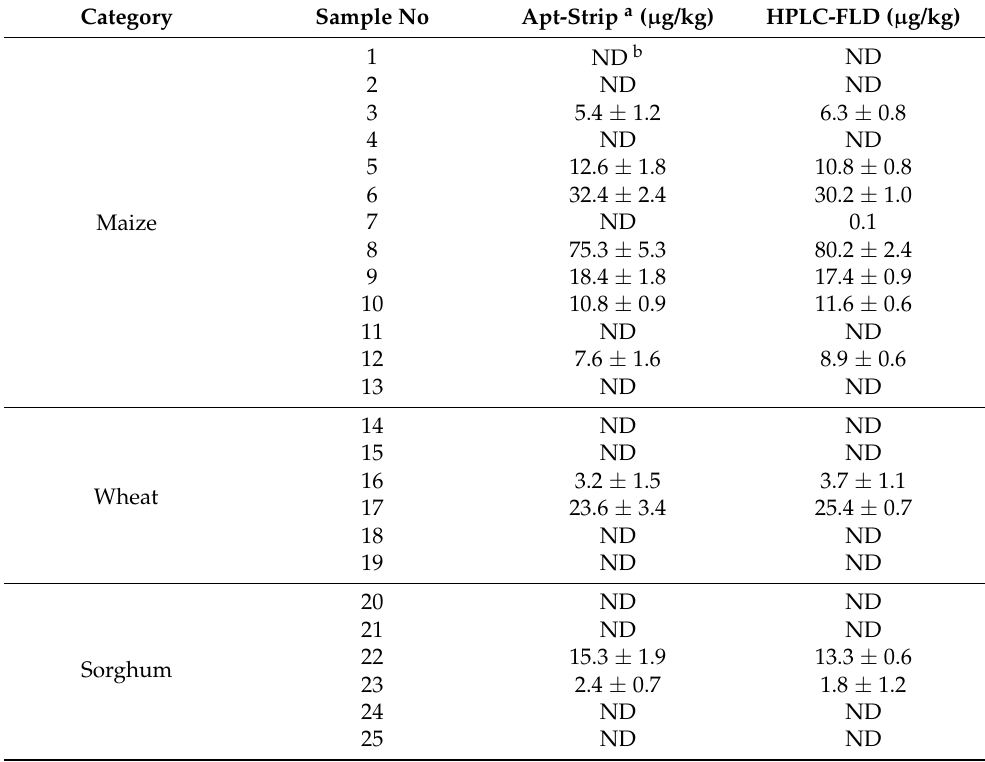
Table 4. Analysis results of the Apt-strip and HPLC-FLD for AFB 1 in maize, wheat, and sorghum samples ( n = 3).